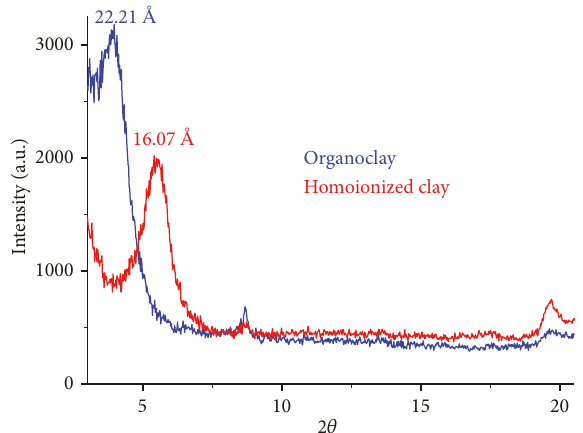
Figure 8: XRD of homoionized clay and